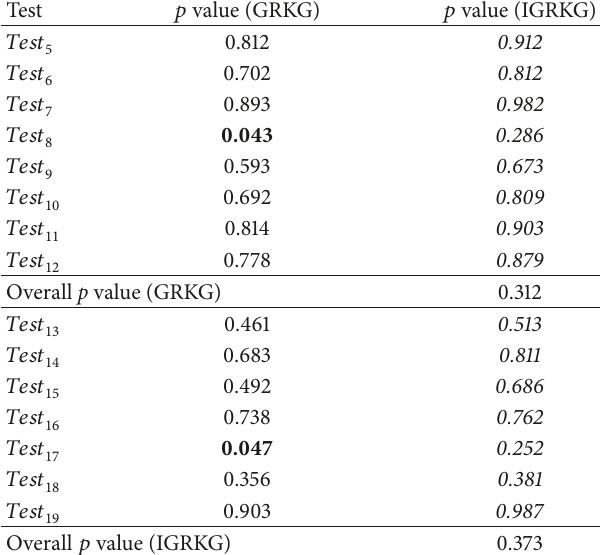
Table 12: Results obtained using Diehard suite ( 𝑇𝑒𝑠𝑡 5 : birthday spacings, 𝑇𝑒𝑠𝑡 6 : GCD, 𝑇𝑒𝑠𝑡 7 : overlapping permutations, 𝑇𝑒𝑠𝑡 8 : mon- key test OPSO, 𝑇𝑒𝑠𝑡 9 : monkey test OQSO, 𝑇𝑒𝑠𝑡 10 : monkey test DNA, 𝑇𝑒𝑠𝑡